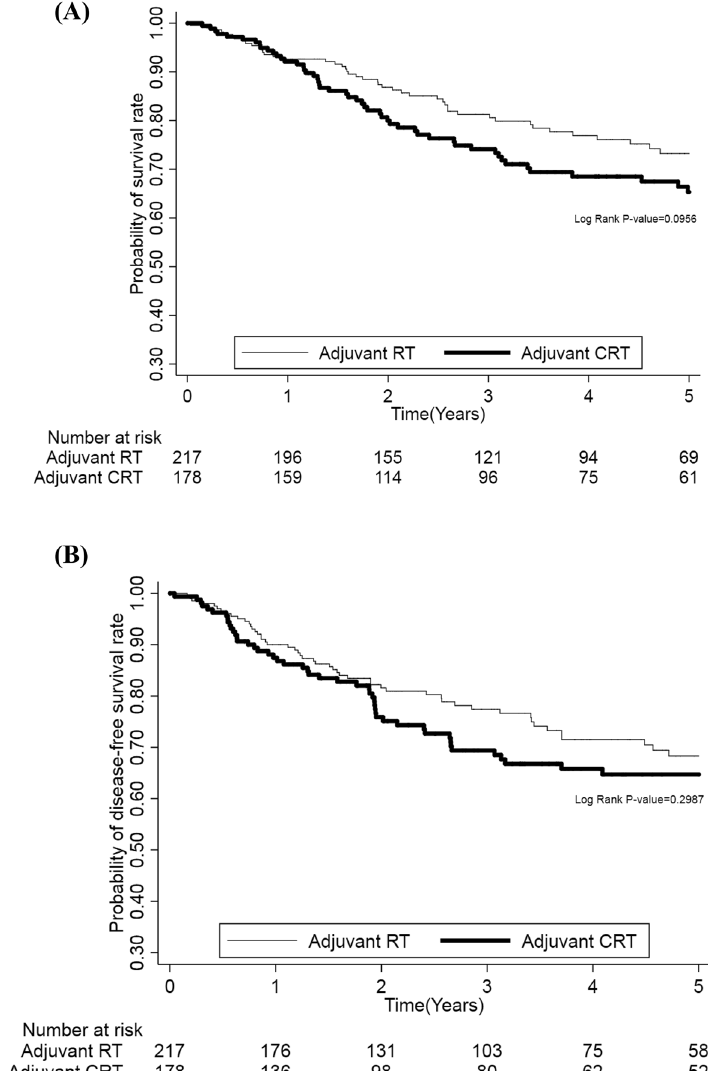
Figure 2. Kaplan–Meier plots of ( A ) overall survival and ( B ) disease-free survival in advanced major salivary gland cancer patients receiving chemoradiotherapy and radiotherapy